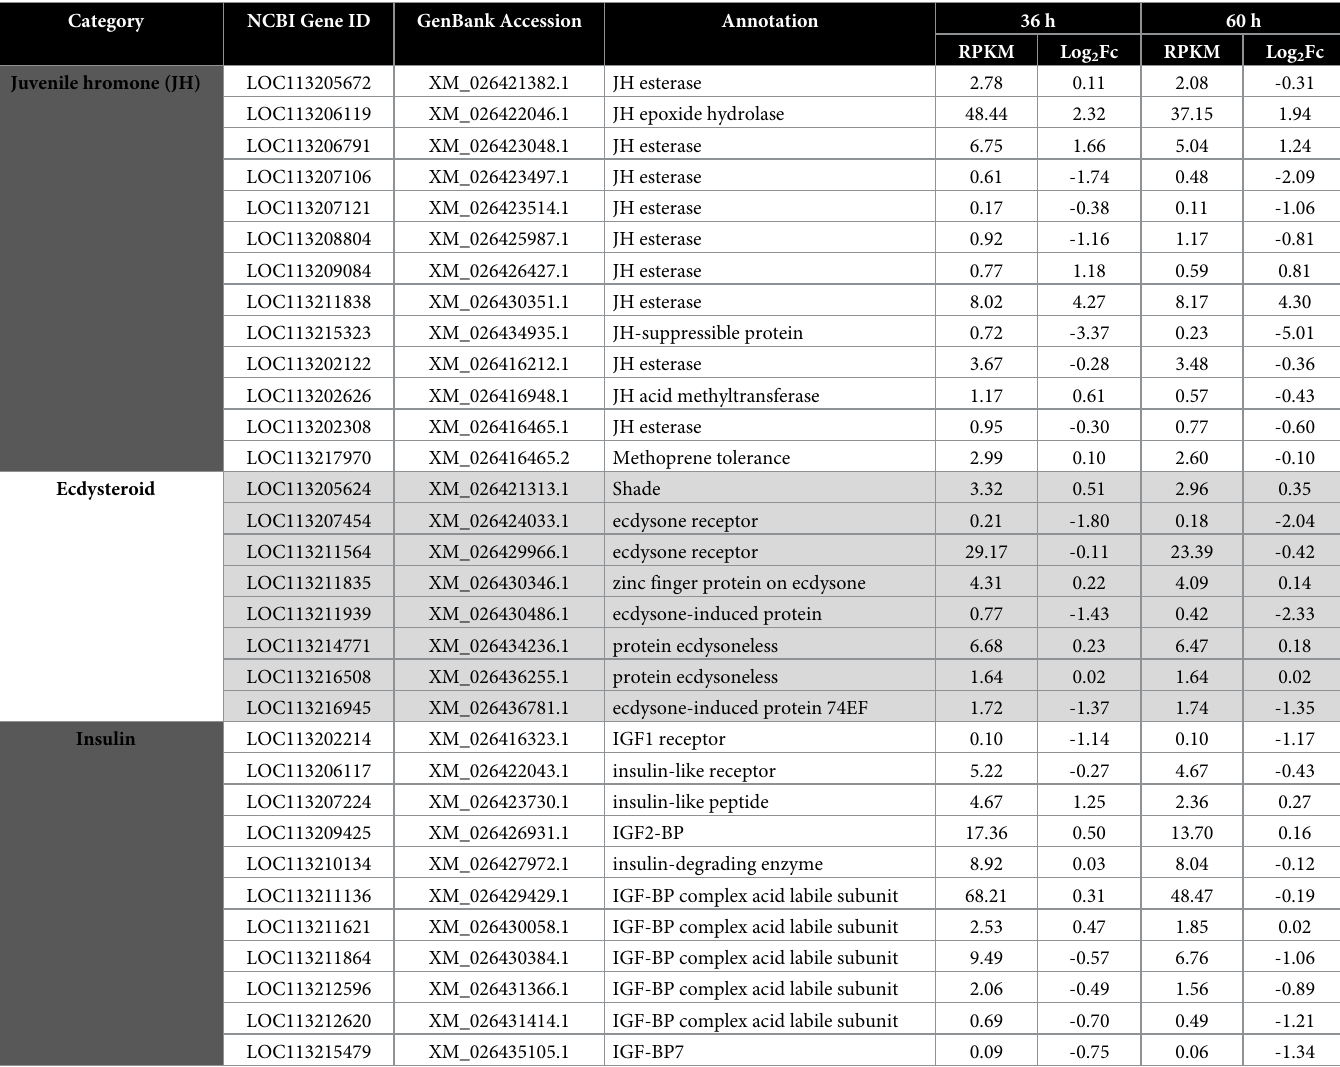
Table 3. DEGs associated with endocrine signals in female F . occidentalis at mid (36 h after adult emergence) and late ovarian development stages compared to the early (0 h) stage.